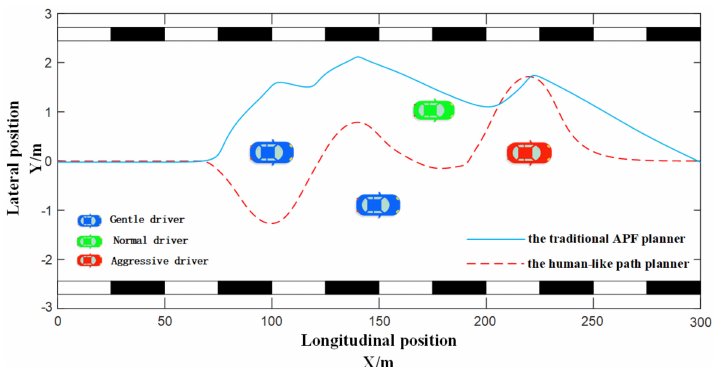
Figure 15. Path planning in overtaking scenes A with various drivers.